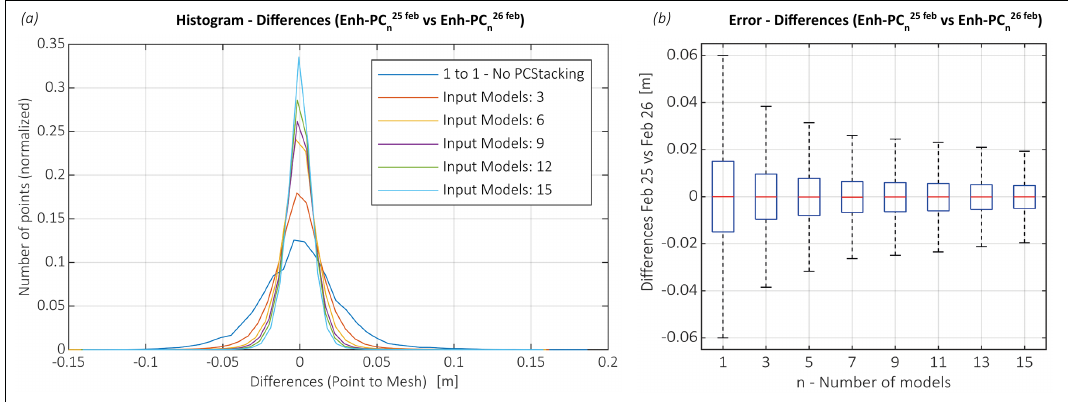
Figure 9. Results from the application of the PCStacking algorithm to real images. ( a ) Histogram of the di ff erences between the Enh-PC n25 feb and Enh-PC n26 feb . Each colored line represents a di ff erent number of PCs introduced into the PCStacking algorithm. ( b ) Error of the di ff erences obtained in the di ff erent comparisons (Enh-PC n25 feb vs. Enh-PC n26 feb ).